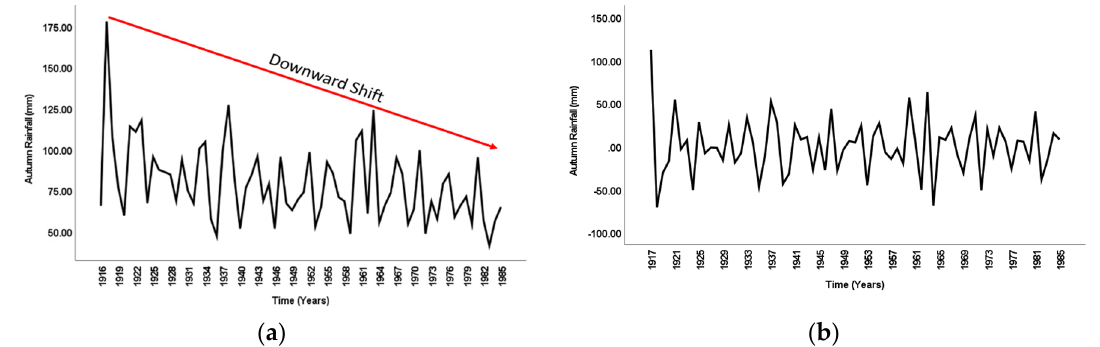
Figure 2. Rainfall data for Albany: ( a ) before differencing and ( b ) after differencing.